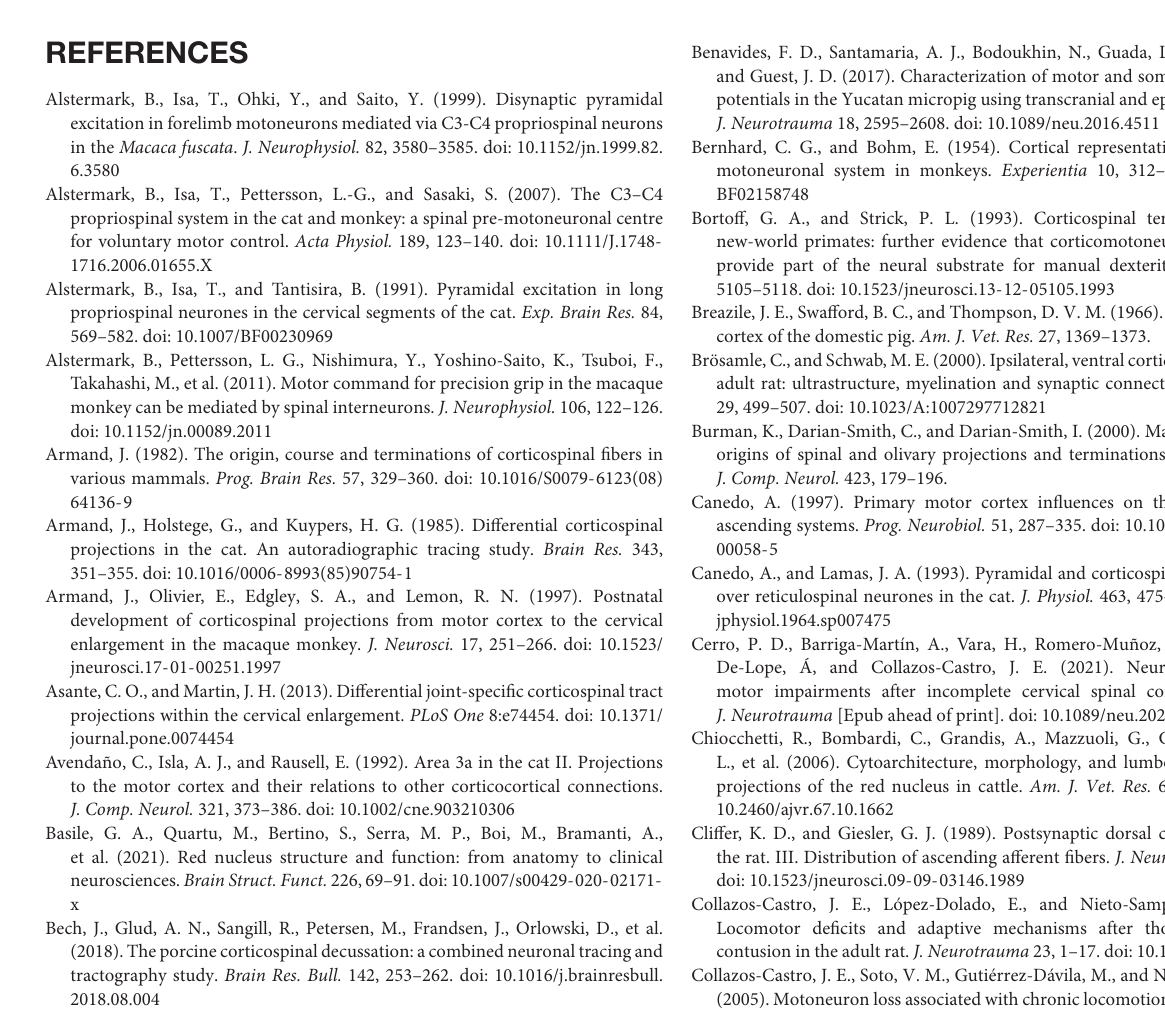
each rostrocaudal coordinate. Neural damage in pig 1 was mostly unilateral and involved the complete right GM, part of the dorsolateral funiculus, the ventromedial funiculus, and the dorsomedial funiculus, where CST axons were located. It also extended to the medial white and gray matter on the left side. Damage was markedly bilateral, and mostly restricted to the gray matter and ventromedial funiculus, in pig 2. Images at bottom correspond to non-stained tissue sections adjacent to those at top, showing the remaining fluorescent aminostilbamidine signal. White matter regions in the lateral funiculus of pig 1 showed intense aminostilbamidine labeling in the side ipsilateral (right, red asterisks), but not contralateral (left, white asterisks) to the injections. Scale bar, 1 mm. Supplementary Figure 2 | Confocal fluorescence images of porcine spinal cord sections processed for neurofilament (NF, green) and microtubule-associated protein 2 (MAP2, red) immunohistochemistry, showing the specific labeling of neuronal somas and dendrites by the anti-MAP2 antibody. (A) Gray matter of C3 spinal segment. Scale bar, 100 µ m. (B,C) Magnification of the squares drawn in (A) . The maximum intensity projections shown in (B) were obtained from a z-stack of nine serial optical sections separated 0.84 µ m. Scale bar, 10 µ m. Supplementary Figure 3 | Confocal fluorescence images of spinal cord sections processed for postsynaptic density protein 95 (PSD-95) immunohistochemistry, showing putative synaptic contacts by CST axons in the C3 spinal gray matter. Axons arising from M1 appear in red and PSD-95 in blue. (A) Maximum intensity projections were obtained from a z-stack of seventeen serial optical sections separated 0.42 µ m. (B–D) Single optical sections from (A) . Scale bar, 5 µ